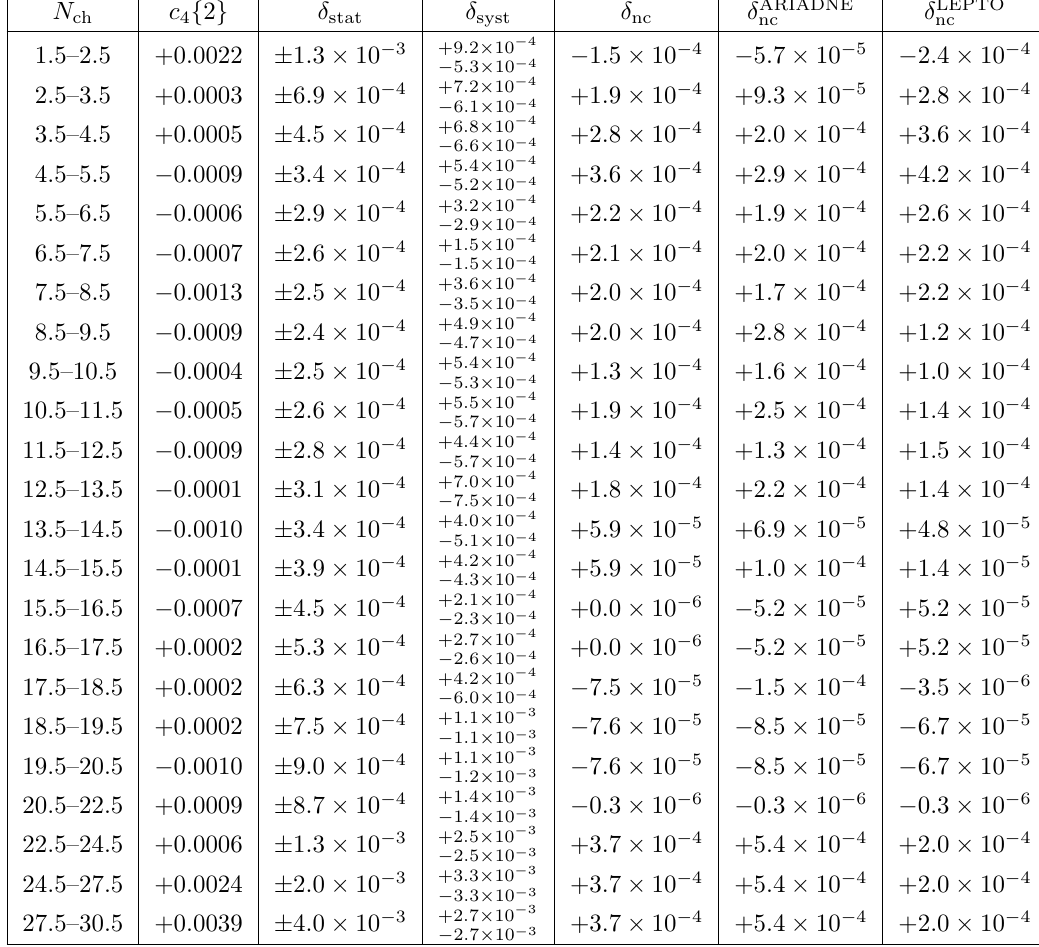
Table 11 . c 4 f 2 g versus N ch from (cid:12)gure 7 (d), p T > 0 : 1 GeV, j (cid:1) (cid:17) j > 2; (cid:14) stat , (cid:14) syst and (cid:14) nc denote the statistical, systematic and Monte Carlo non-closure uncertainties,